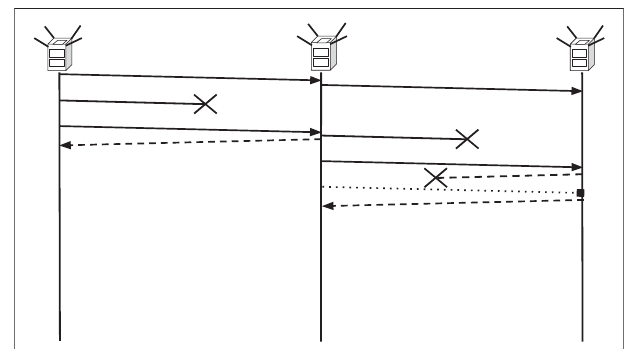
FIGURE 3 | Illustration of the RLNC for the case of two segments and two hops. The vertical lines represent increasing time from top to bottom, and we assume a high fi eld size for the sake of simplicity. The solid arrows represent coded segments, whereas the dashed arrows represent